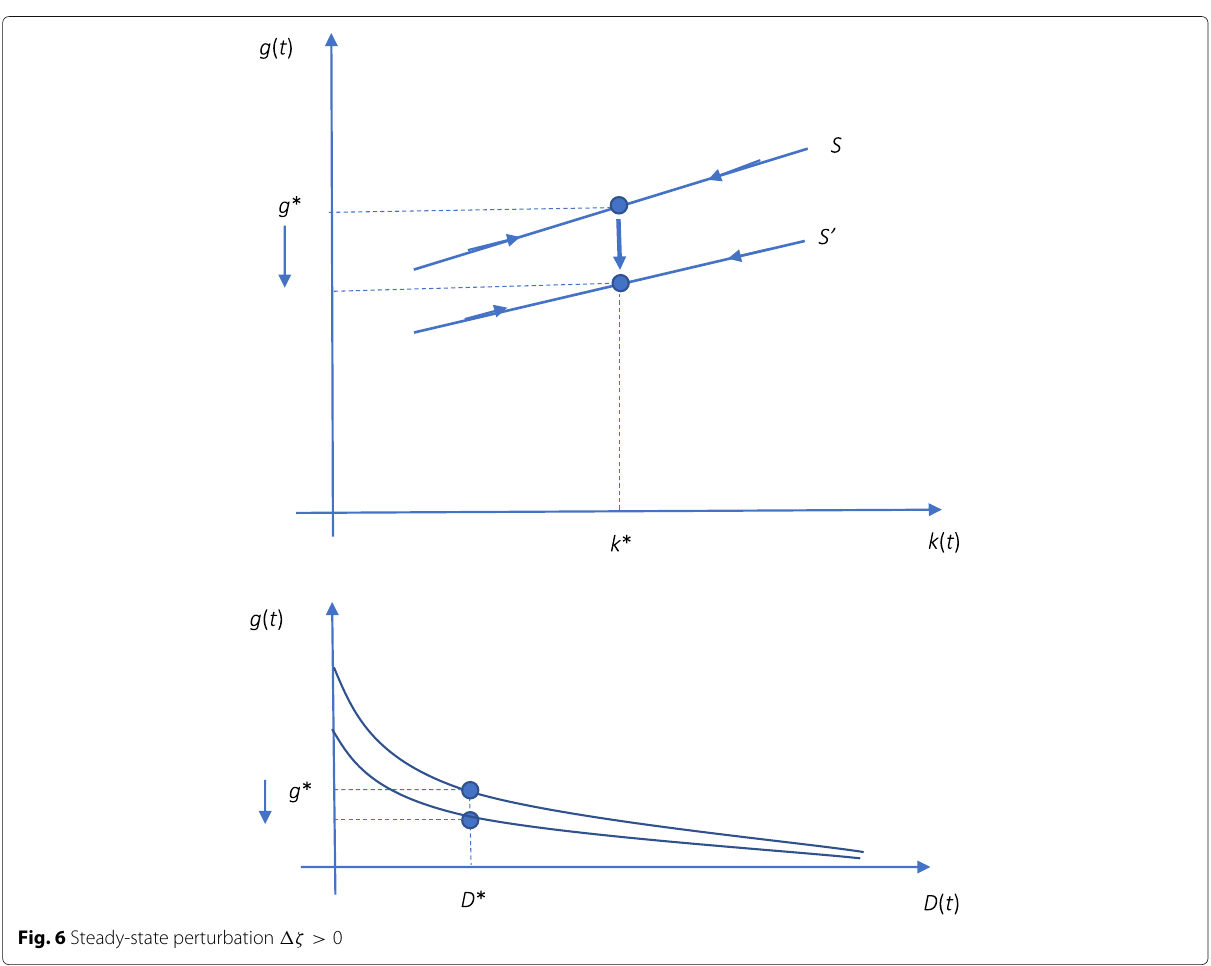
Fig. 6 Steady-state perturbation (cid:9)ζ >